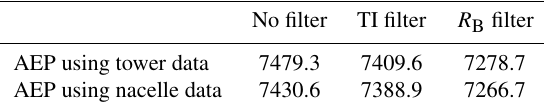
Table 5. AEP in megawatt-hours per year calculated for different at- mospheric and turbulence regimes using a Weibull distribution with a scale and shape parameter associated with the corresponding wind speed distribution.